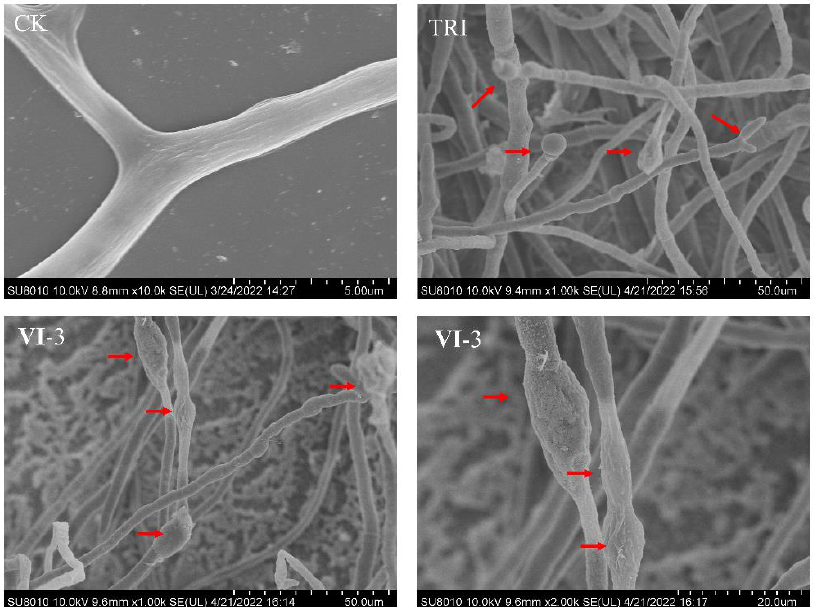
Figure 3. The mycelium growth inhibition of S. sclerotiorum treated with VI - 3 and TRI by SEM.